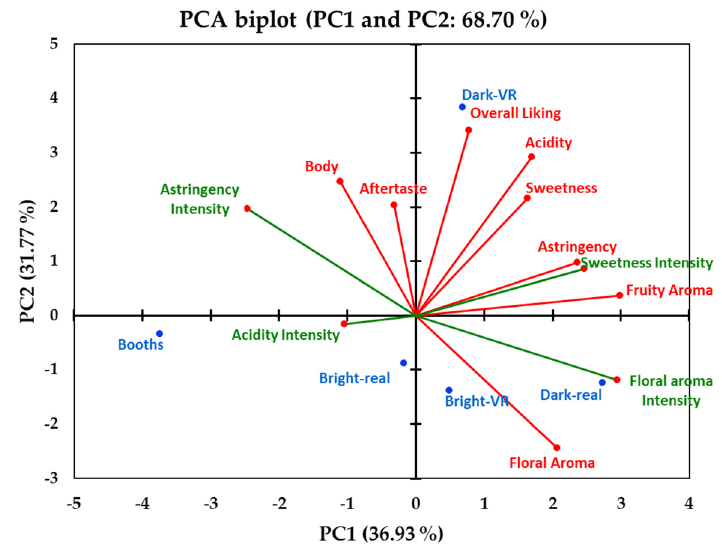
Figure 4. Principal component analysis (PCA) biplot visualizing treatments 1 (wine sample in each environment), acceptability (liking; vectors in red color), and intensity attributes (vectors in green color). 1 Booths = traditional sensory booths, Bright ‐ real = bright restaurant real environment, Dark ‐ real = dark restaurant real environment, Bright ‐ VR = bright restaurant VR environment, and Dark ‐ VR = dark restaurant VR environment.